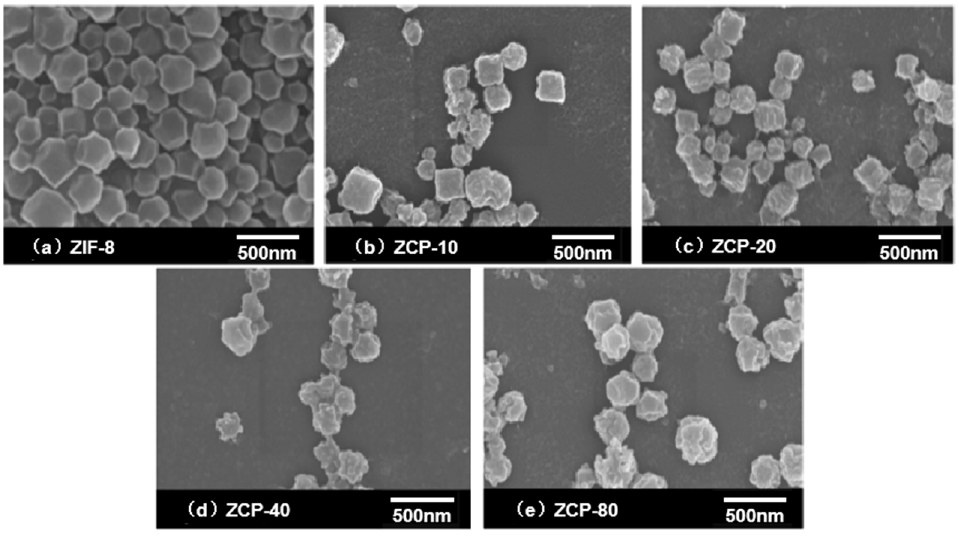
Figure 1. SEM images of ZIF-8 and